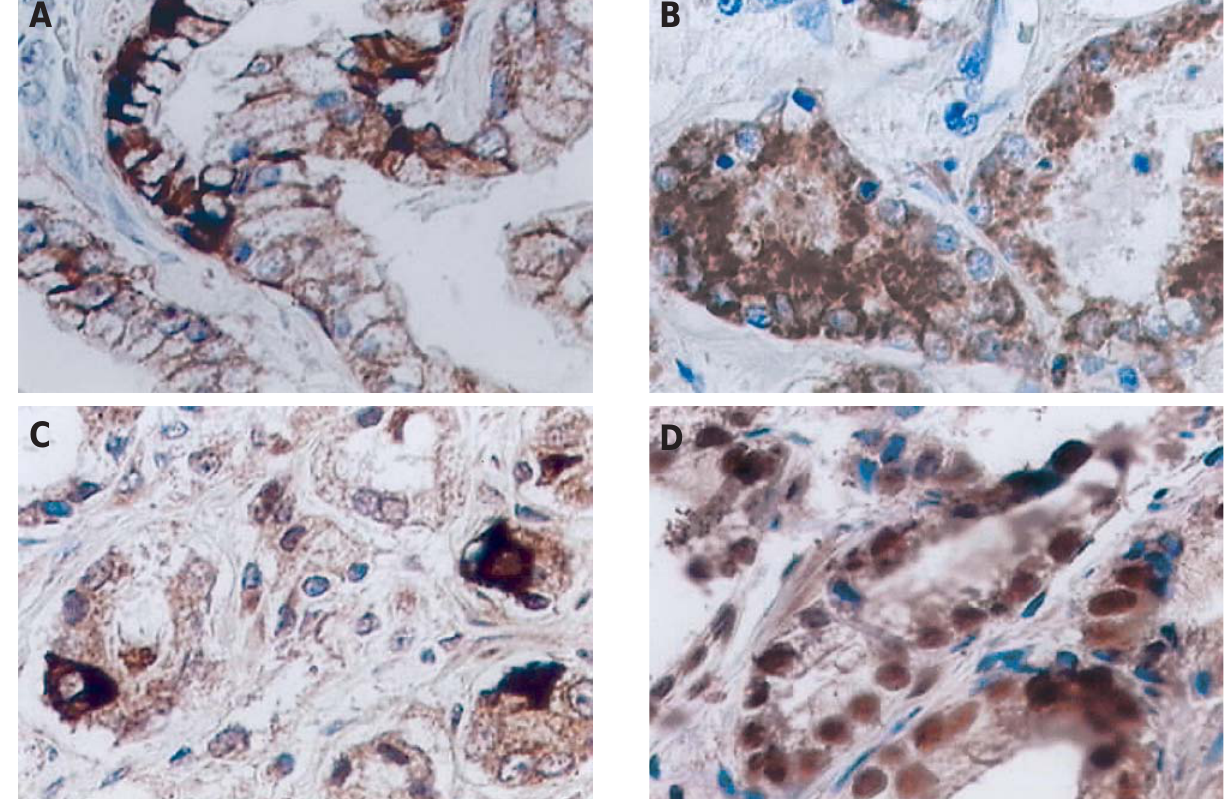
Figure 1 – Prostatic tumor with expression of different immunomarkers. A) Variation in the E-caderin expression, with focal membrane labeling and cytoplasmic pattern. B) Cytoplasmic expression of E-caderin with loss of membrane expression. C) Neuroendocrine differentiation with positivity for chromogranin-A. D) Strong nuclear expression for